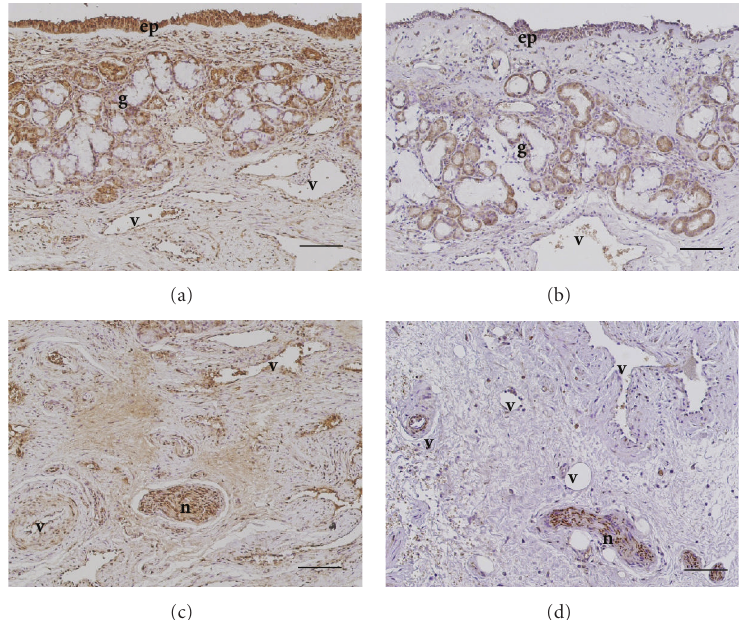
Figure 2: Immunohistochemical staining for bradykinin B2 receptor in human allergic (a), (c), (e) and nonallergic (b), (d), (f) nasal mucosa. Inferior turbinates were stained with antihuman B2 receptor antibody (a)–(d) or normal rabbit immunoglobulin (e), (f). Immunoreactivity for B2 receptor was significantly detected in submucosal glands (), epithelial cells (c), vascular smooth muscle (c), (d), nerve bundle, and fibroblasts (d). ep: epithelial cells; v: blood vessels; g: submucosal glands; n: nerves. Scale bar = 100 μ m.